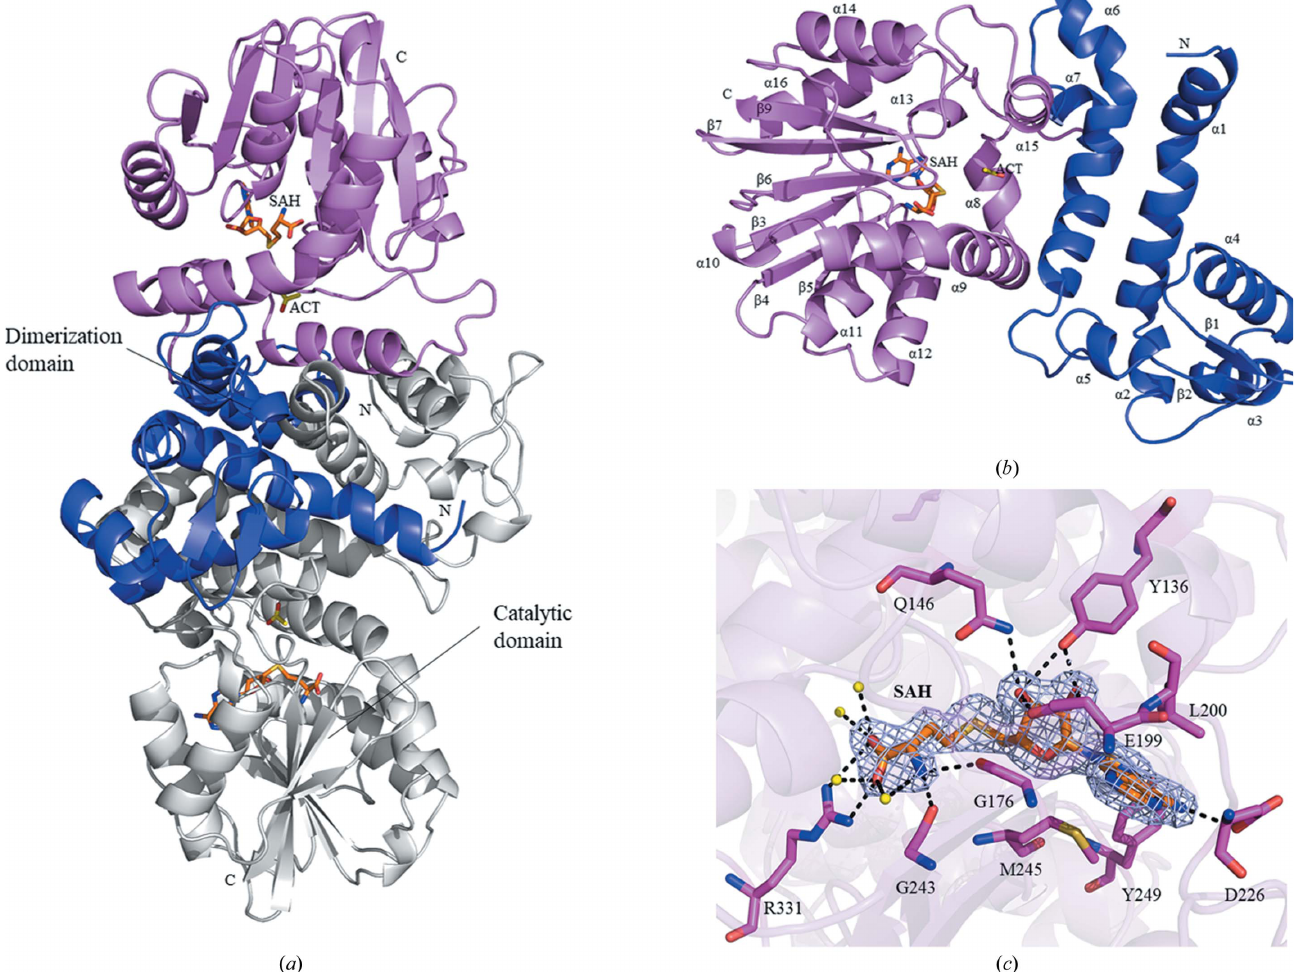
Figure 5 The structure of the complex of PigF with the cofactor SAH. ( a ) The structure of the PigF dimer present in the asymmetric unit with the cofactor SAH. The dimerization domain of subunit A is coloured blue and the catalytic domain is coloured violet. Subunit B is coloured grey. SAH and acetate (ACT) are shown as orange and yellow sticks, respectively. ( b ) Chain A of PigF with the cofactor SAH. Individual domains are coloured blue and violet, respectively. SAH (C atoms in orange) is shown in the SAH binding domain. ( c ) The SAH binding site. SAH is coloured orange, residues are shown as magenta sticks, water molecules are shown as yellow spheres and hydrogen bonds are shown as dotted lines and coloured black; the cartoon representation of the PigF–SAH structure is shown with 80%